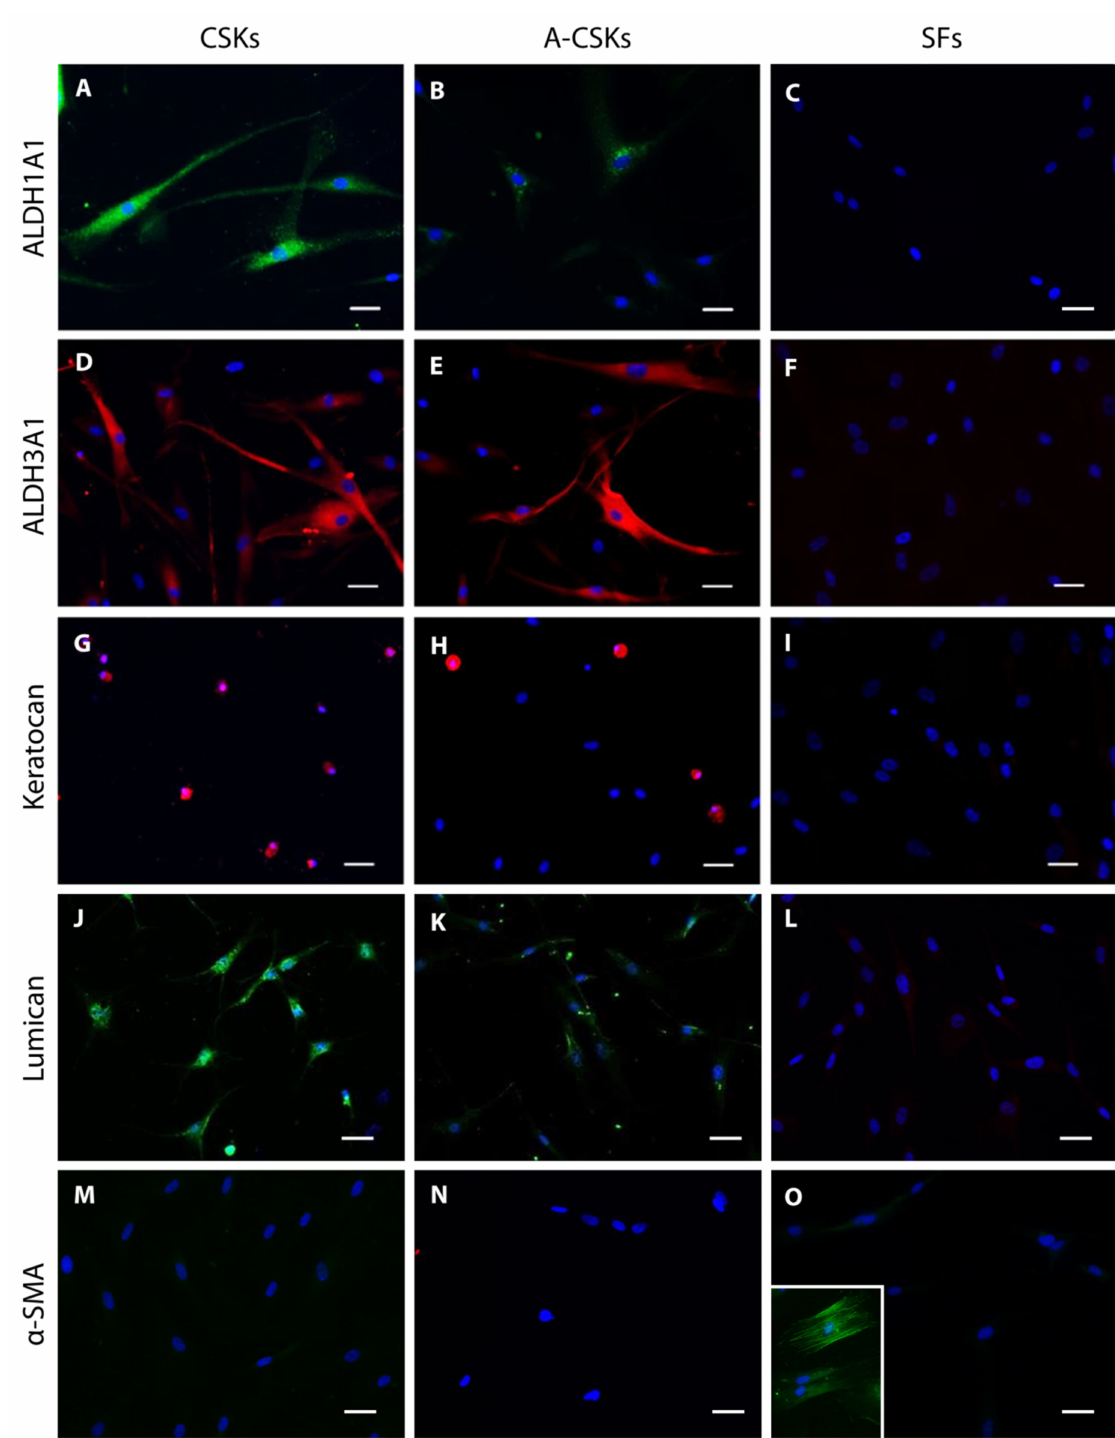
Figure 5. Protein expression of corneal stromal keratocytes (CSKs), activated CSKs (A-CSKs), and corneal fibroblasts (SFs). ( A , D , G , J ) Typical CSK markers, such as ALDH1A1, ALDH3A1, keratocan, and lumican were strongly expressed in the CSKs following 14 days of culture media switching to serum-free conditions. ( B , E , H , K ) In the propagation medium, the A-CSKs exhibited an attenuated expression of the CSK markers. ( C , F , I , L ) In contrast, in medium supplemented with 5% FBS, the SFs did not express or express only a little of the CSK markers. ( M , N , O ) All three cell types were not im- munoreactive with α -smooth muscle actin ( α -SMA), the cell marker of corneal stromal myofibroblasts (see inset in pane O). Scale bars = 50 µ